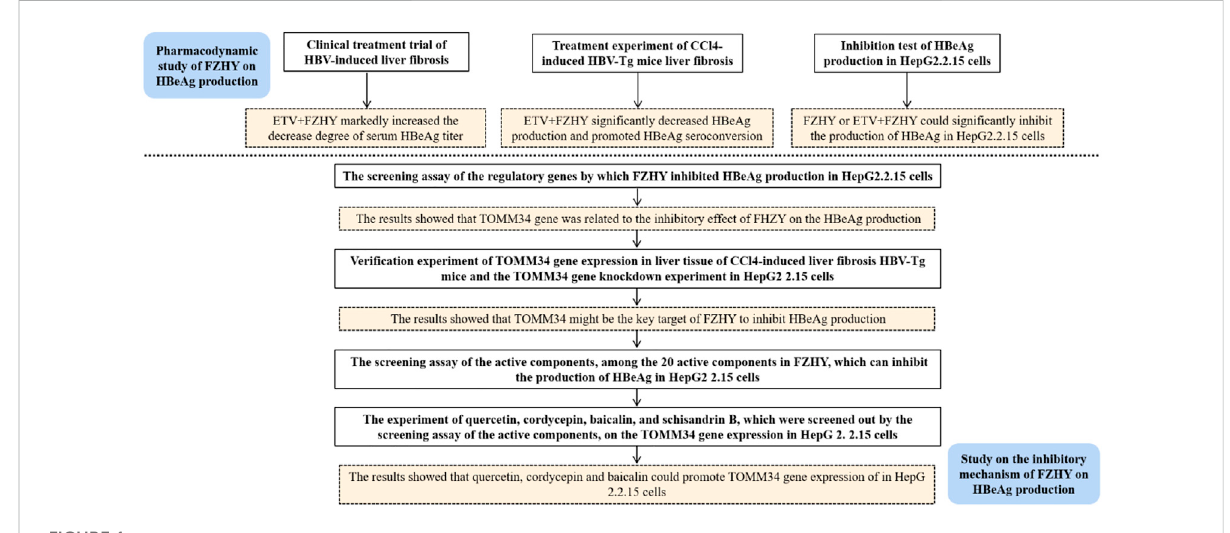
FIGURE 1 The fl owchart of the